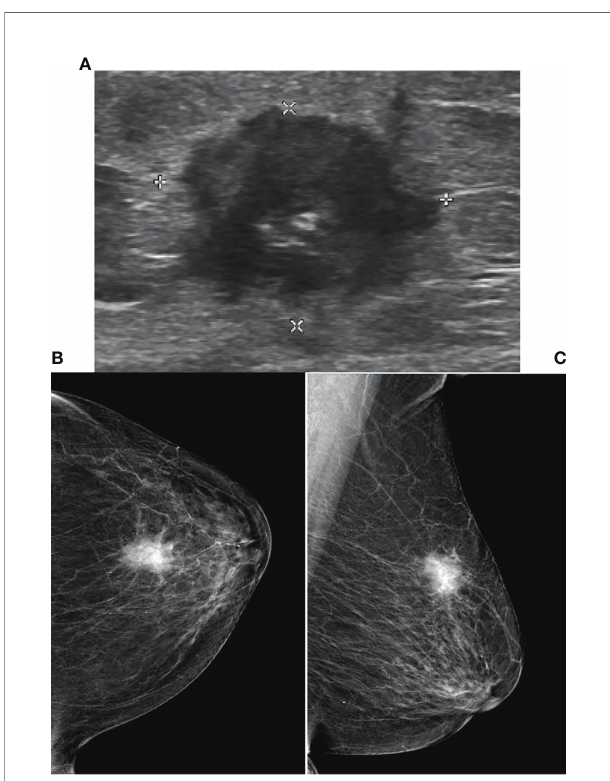
FIGURE 2 | Ultrasound and Mammography images for breast cancer. Legend: Female, 80, invasive carcinoma of left breast. (A) showed irregular heterogeneous echo in left breast, spiculated margins. The mammography of CC (B) and MLO (C) of left breast showed high-density mass, obscure margins, and clustered microcalci fi cations in the